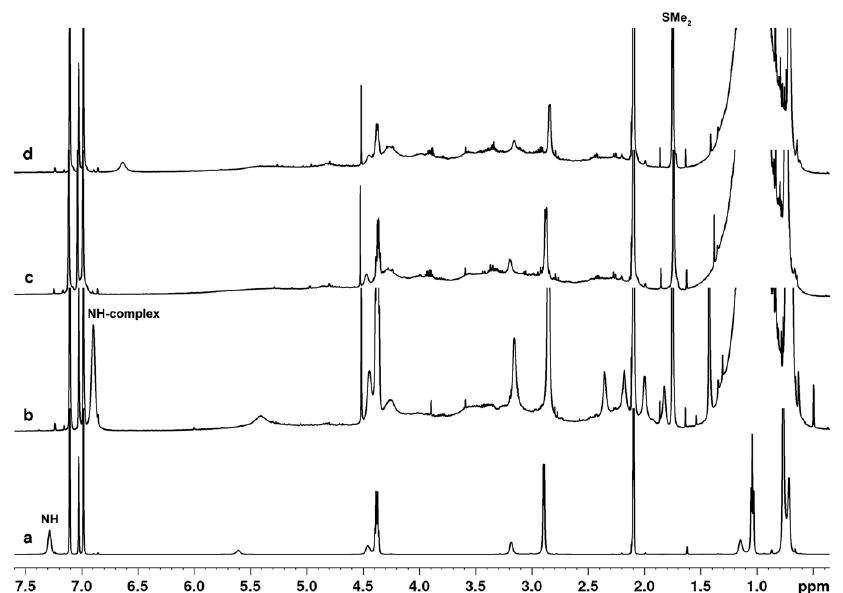
Figure 8. 1 H NMR spectra of: ( a ) pure ligand 6 in toluene-d 8 , and mixture of 6 and BH 3 •SMe 2 in toluene-d 8 measured at different time intervals after sample preparation: ( b ) 15 min, ( c ) 3 h 30 min and ( d ) 5 h.